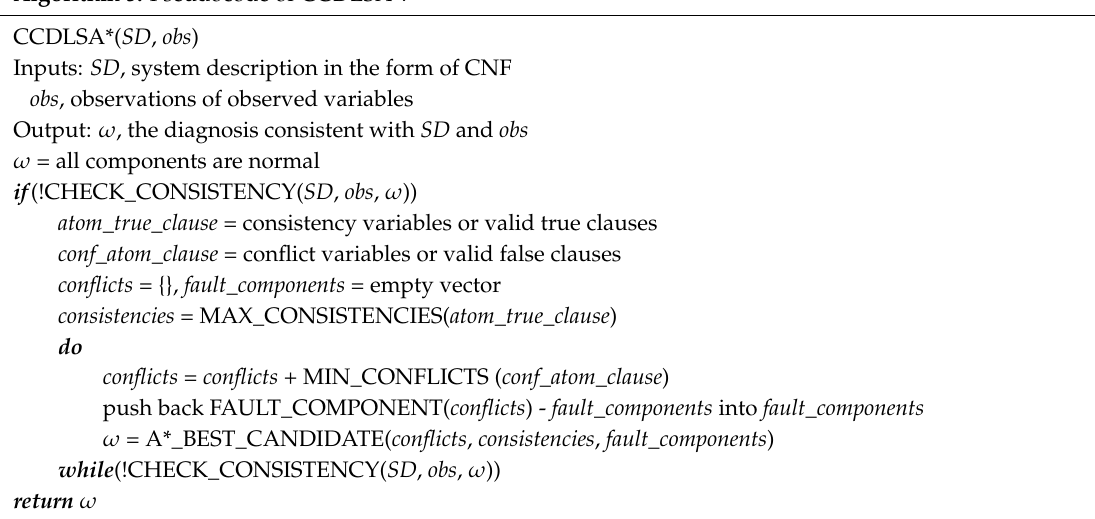
Algorithm 5. Pseudocode of CCDLSA*.